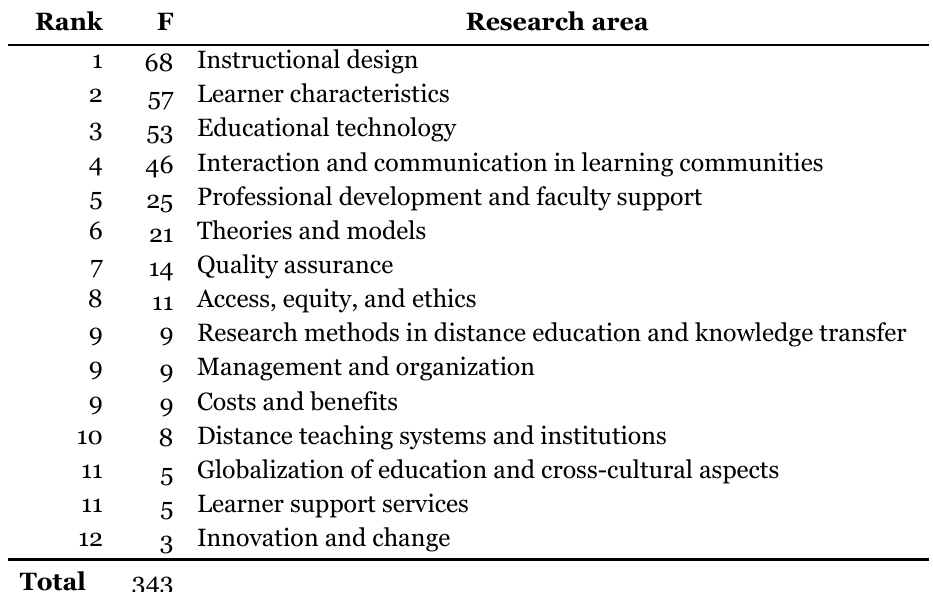
Distribution of Research Areas from 2011–2015 (N = 343)